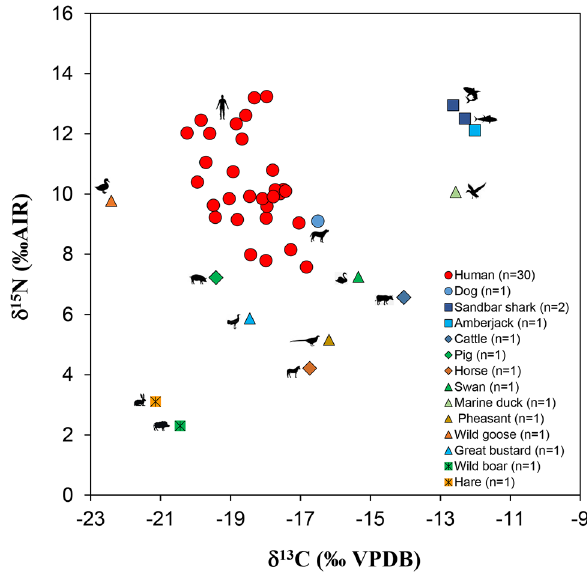
Figure 2. Bulk δ 13 C and δ 15 N values of human and fauna remains from Joyeung E (I, II, III) burials in this